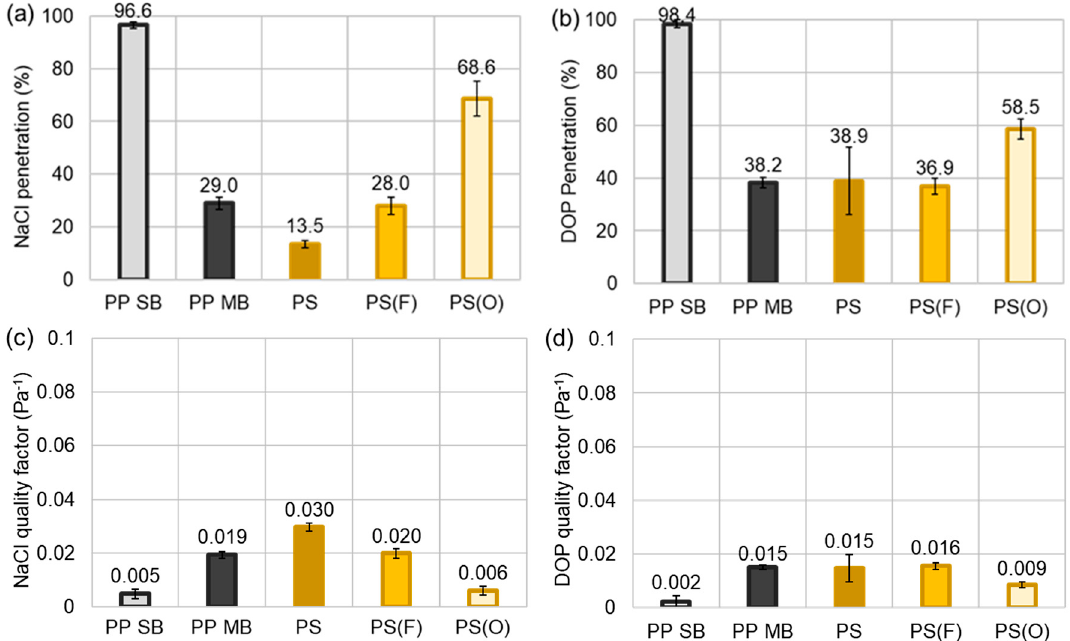
Figure 5. Filtration performance for NaCl and DOP. ( a ) % Penetration of NaCl; ( b ) % Penetration of DOP; ( c ) Quality factor for NaCl; ( d ) Quality factor for DOP. Note: PP SB is two layers of PP SB.